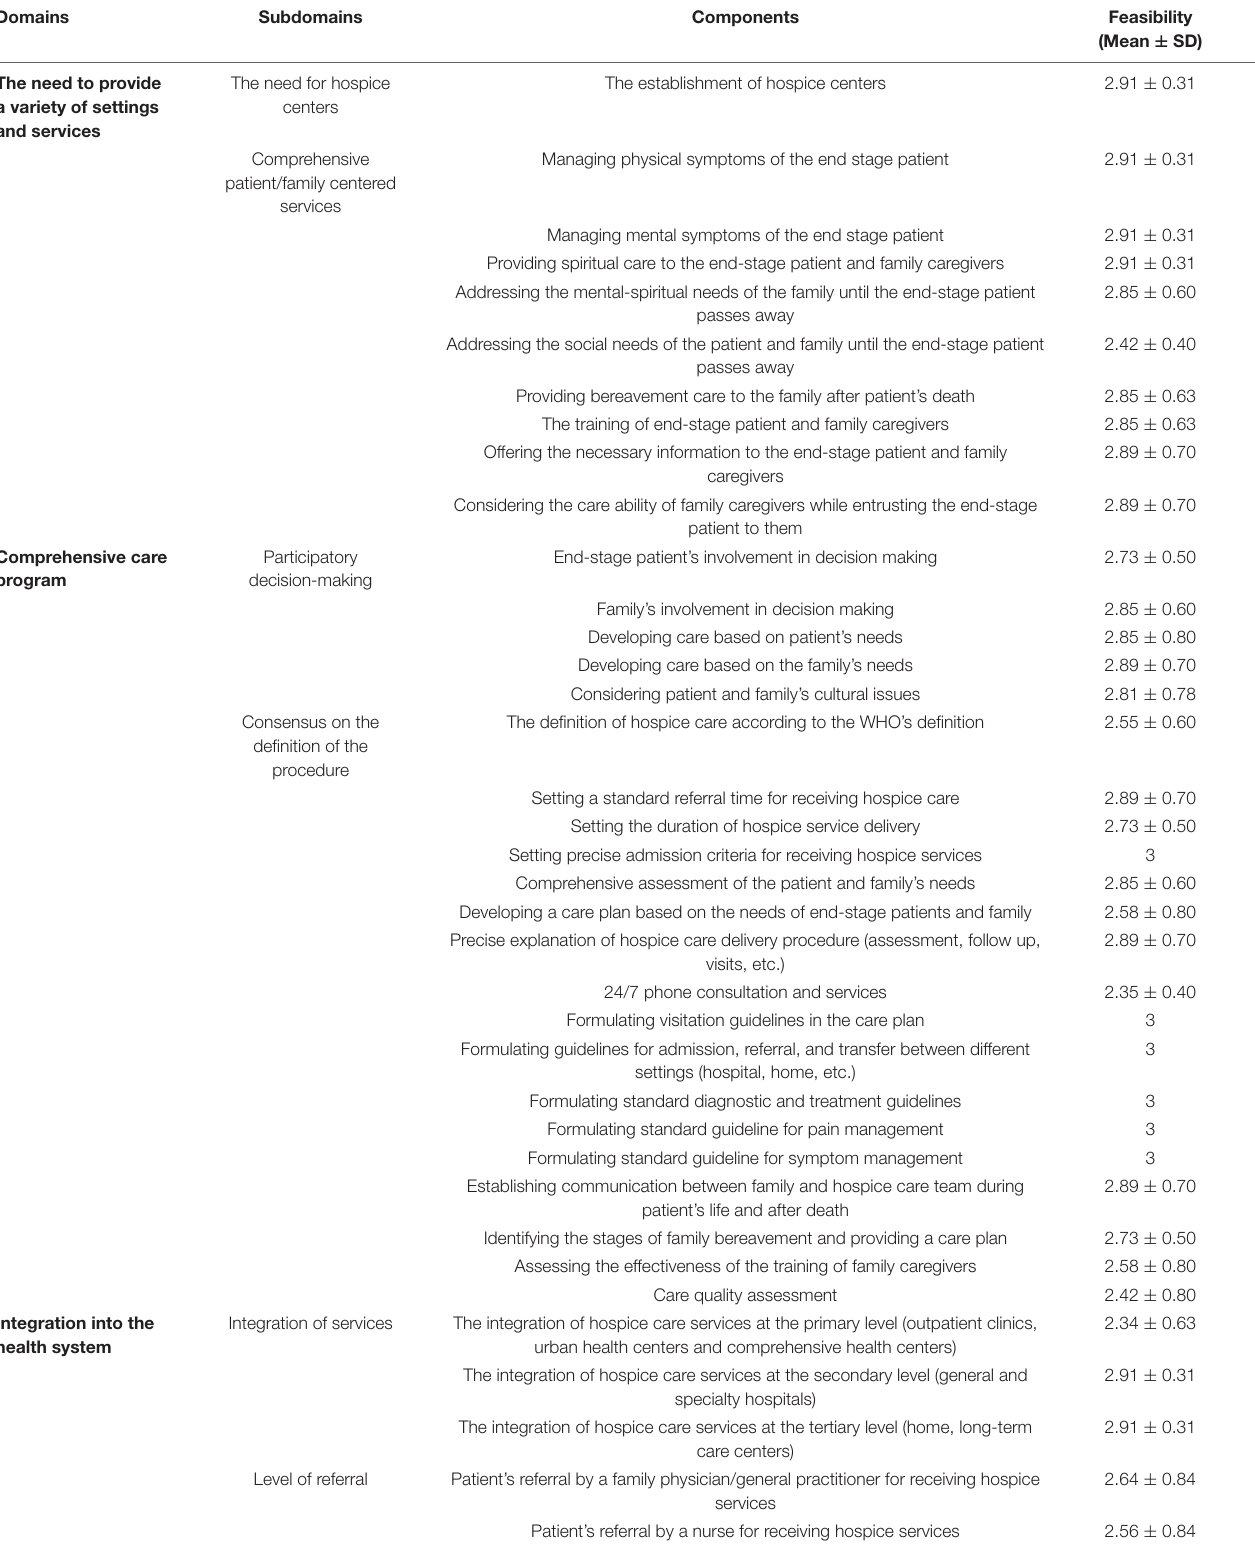
TABLE 4 | The mean, minimum and maximum score of the Feasibility of components in Phase 4 (minimum mean score = 1, maximum mean score = 4).